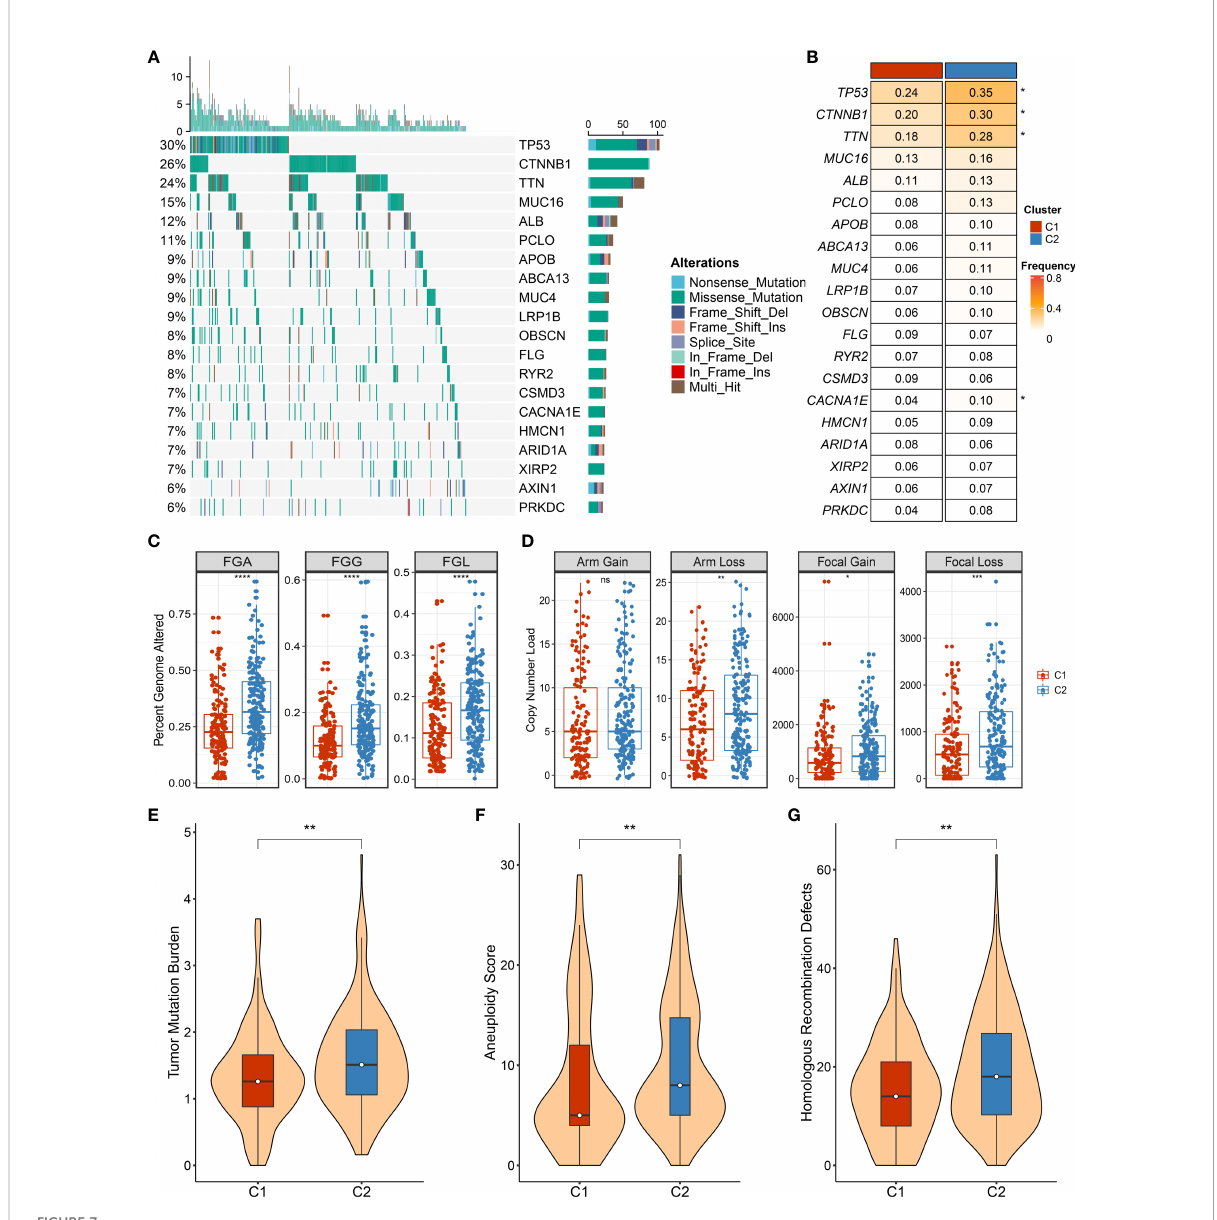
FIGURE 7 The landscape of genomic alternations in necroptosis subtypes. (A) The overview of somatic mutation with top 20 frequently mutated genes (FMGs) by waterfall plot. The right panel shows the mutation rate, and genes are ordered by their mutation frequencies. (B) Comparison of top 20 FMGs between necroptosis subtypes. (C) Distributions of fraction of genome alteration (FGA), fraction of genomic gained (FGG), and fraction of genome lost (FGL) between necroptosis subtypes. (D) Distributions of arm gain, arm loss, focal gain, and focal loss. (E) Distribution of tumor mutational burden (TMB) between necroptosis subtypes. (F,G) The comparison of aneuploidy score (F) and homologous recombination de fi ciency (HRD) (G) between necroptosis subtypes. ns, p >0.05, *p < 0.05, **p < 0.01, ***p < 0.001, ****p <